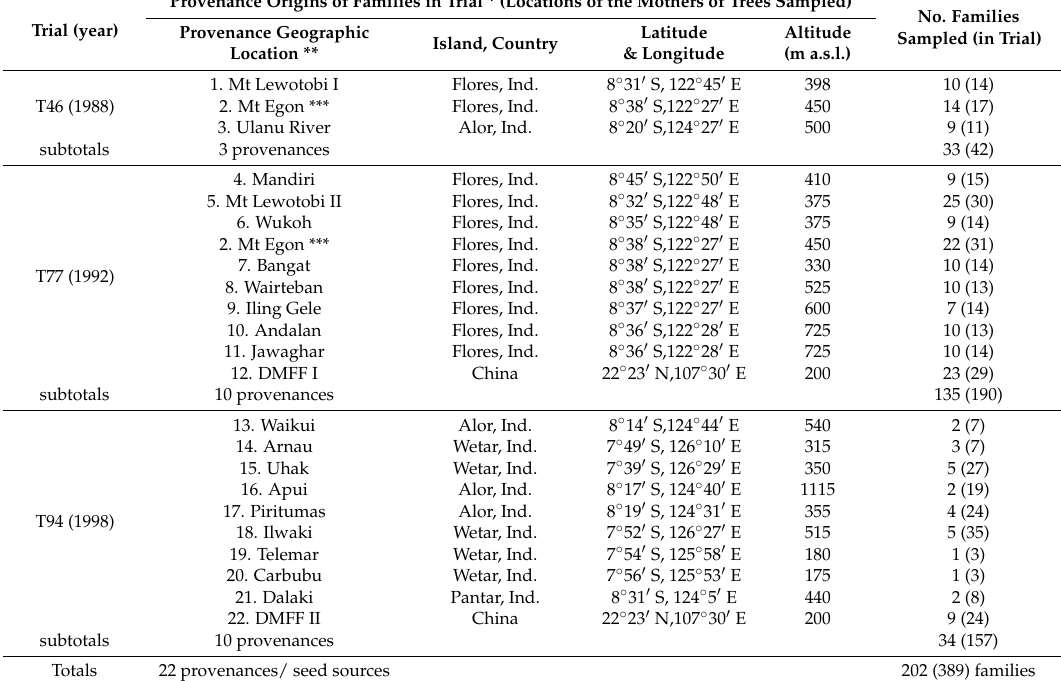
Table 1. Details of the samples obtained from 3 field trials (T46, T77 and T94) of the first cycle breeding population of E. urophylla .